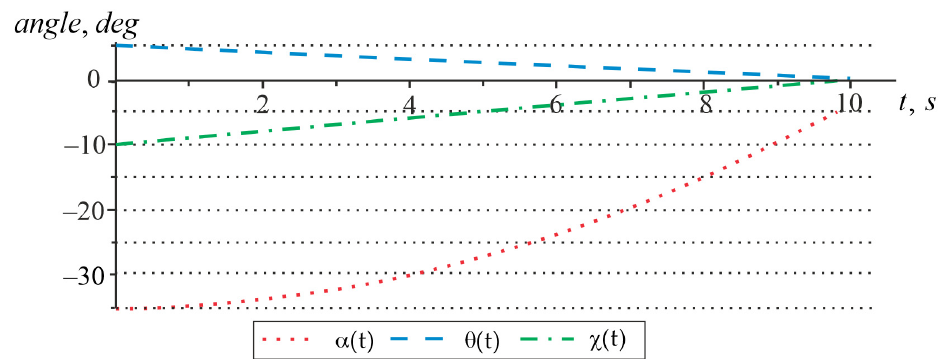
Figure 14. Changes in the angles of sliding, roll, and attack while a helicopter is landing.